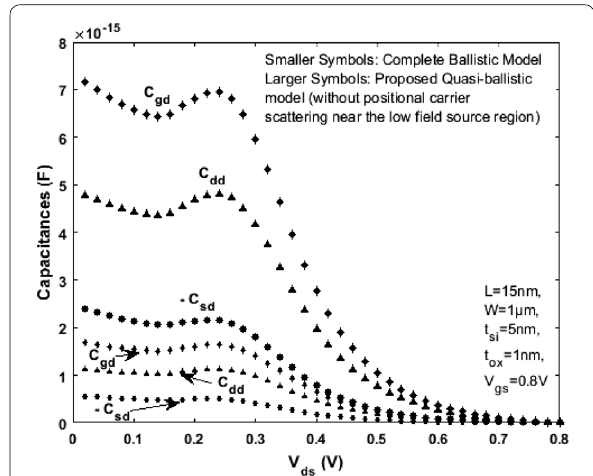
Fig. 10 Variation of capacitances C gd , C dd , C sd as a function of drain voltage V ds . Smaller size symbols are the capacitances as per complete Ballistic model (7) and larger size symbols are capacitances as per the proposed model (9) and (11) with uniform carrier scattering